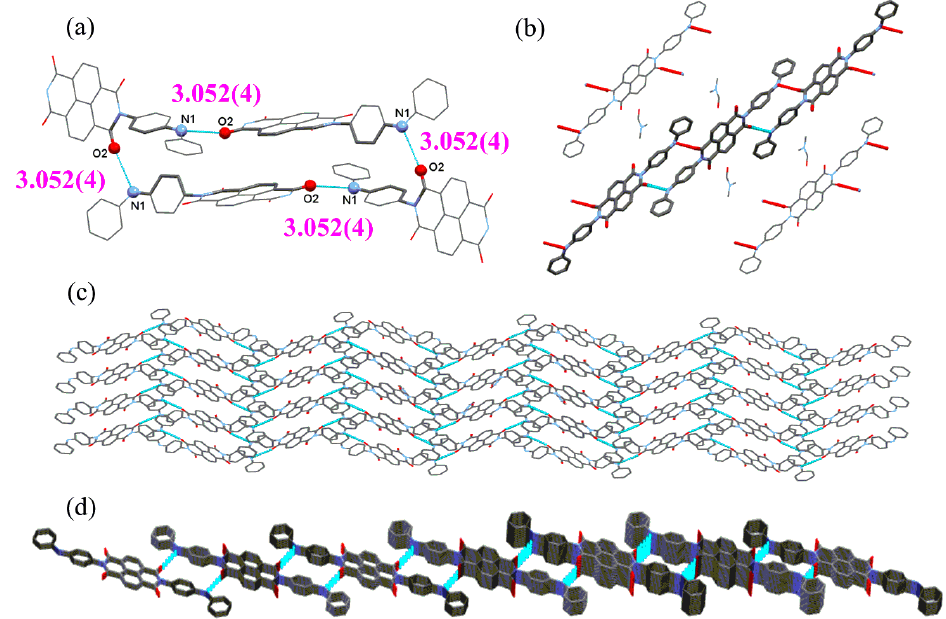
Figure 3. Perspective views for 1 formed by intermolecular N ··· O hydrogen bonds ( a–d ) are presented. A large pore was formed by four molecules with equivalent one type of N ··· O hydrogen bonds ( a ). Views of embedded solvent DMF molecules ( b ), solvent free 2D network ( c ), and channels ( d ) are presented. The greenish blue dashed line represents the intermolecular N ··· O hydrogen bonds. The red dashed line represents hanging contacts.